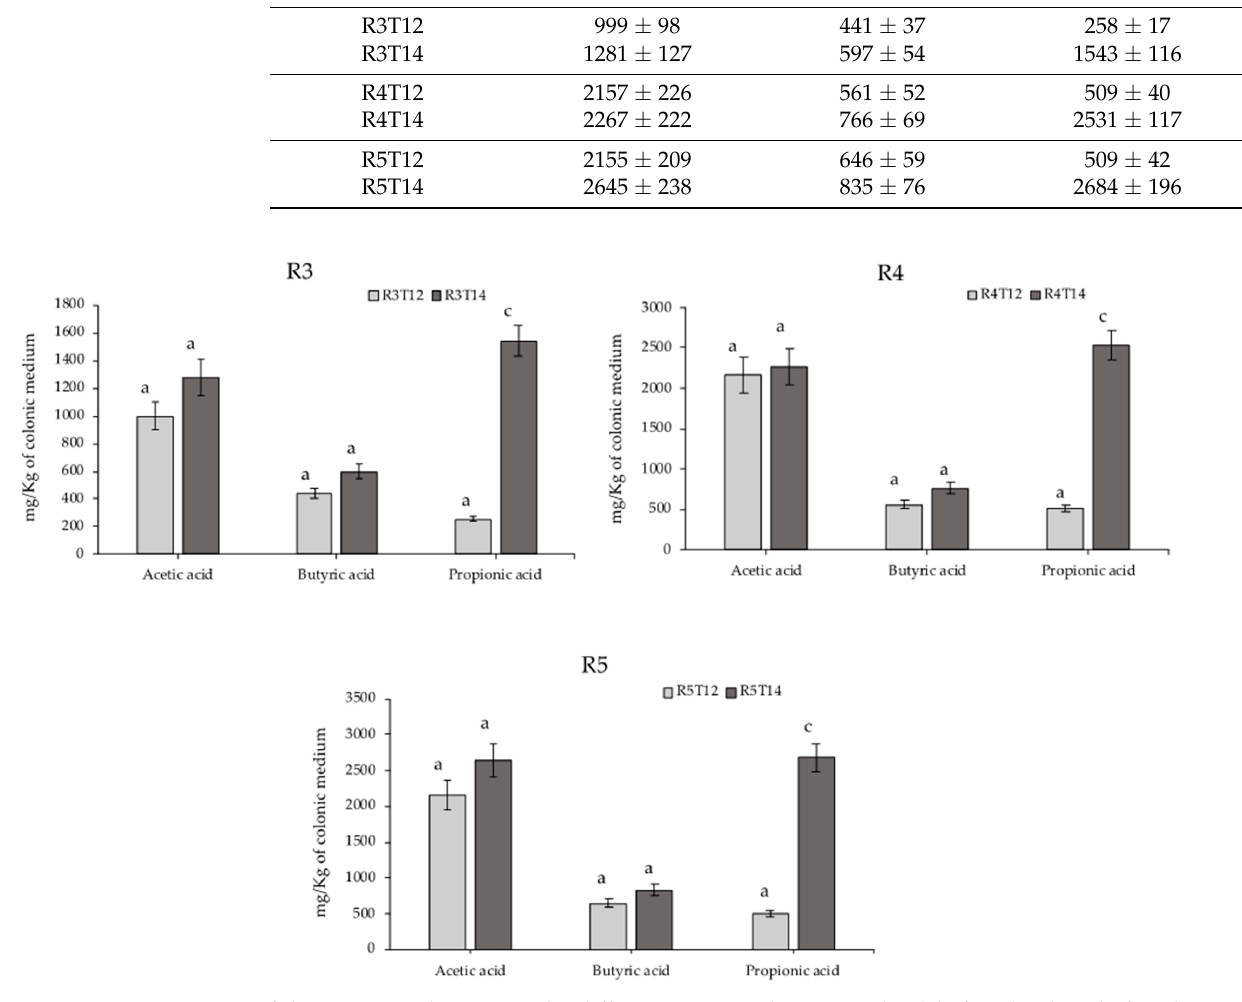
Figure 2. Representation of the SCFA production on the different reactors: ( R3 , R4 and R5 ) before (T12) and after the treatment (T14) ( n = 2 ± SD). A Mann–Whitney U Test was applied for differences between two groups on a single, ordinal variable with no specific distribution. Different letters mean statistically significant differences: a, no significant difference ( p > 0.05) and c, a very significant difference ( p <